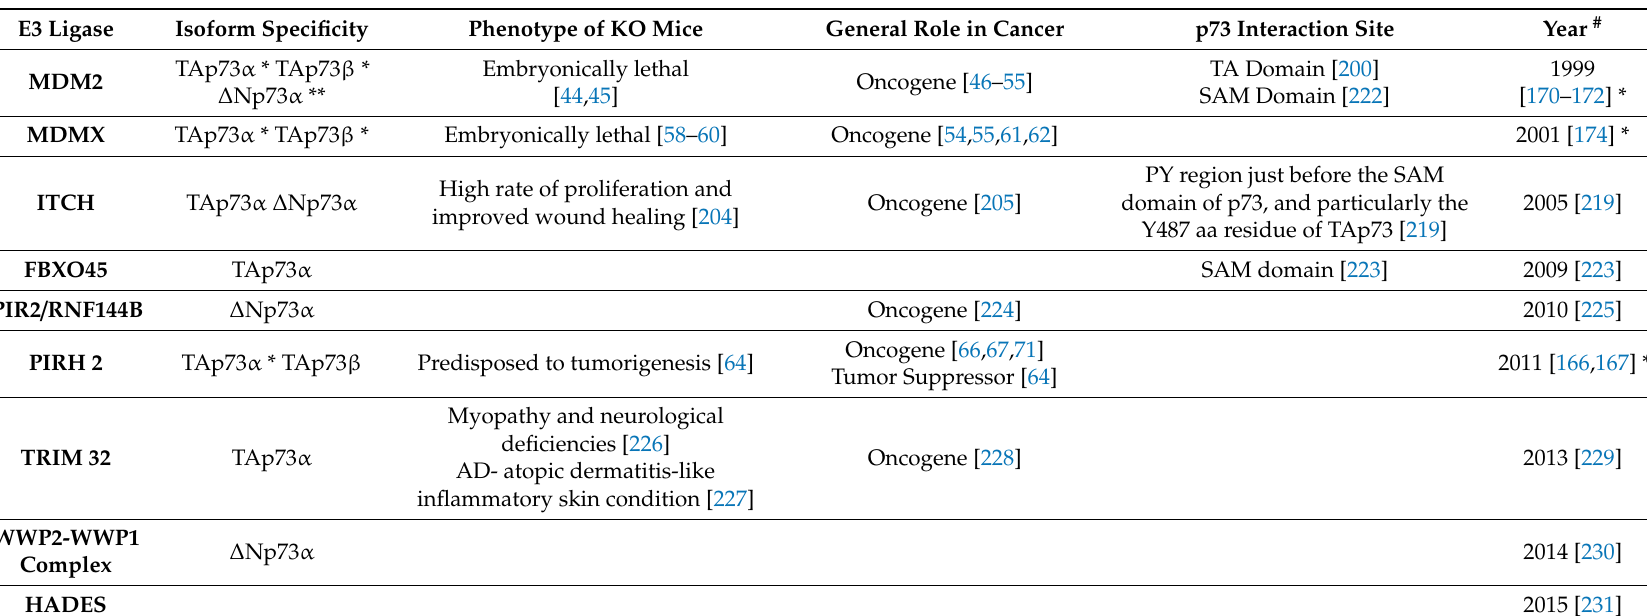
Table 4. Ubiquitin E3 Ligases for